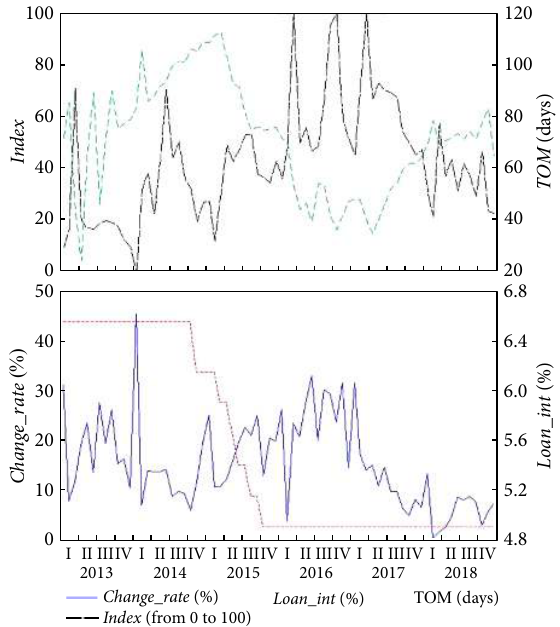
Fig. 2 Time series trend of Change_rate, TOM, Index, and Loan_int. Ⅰ , Ⅱ , Ⅲ , and Ⅳ represent four quarters of the years.